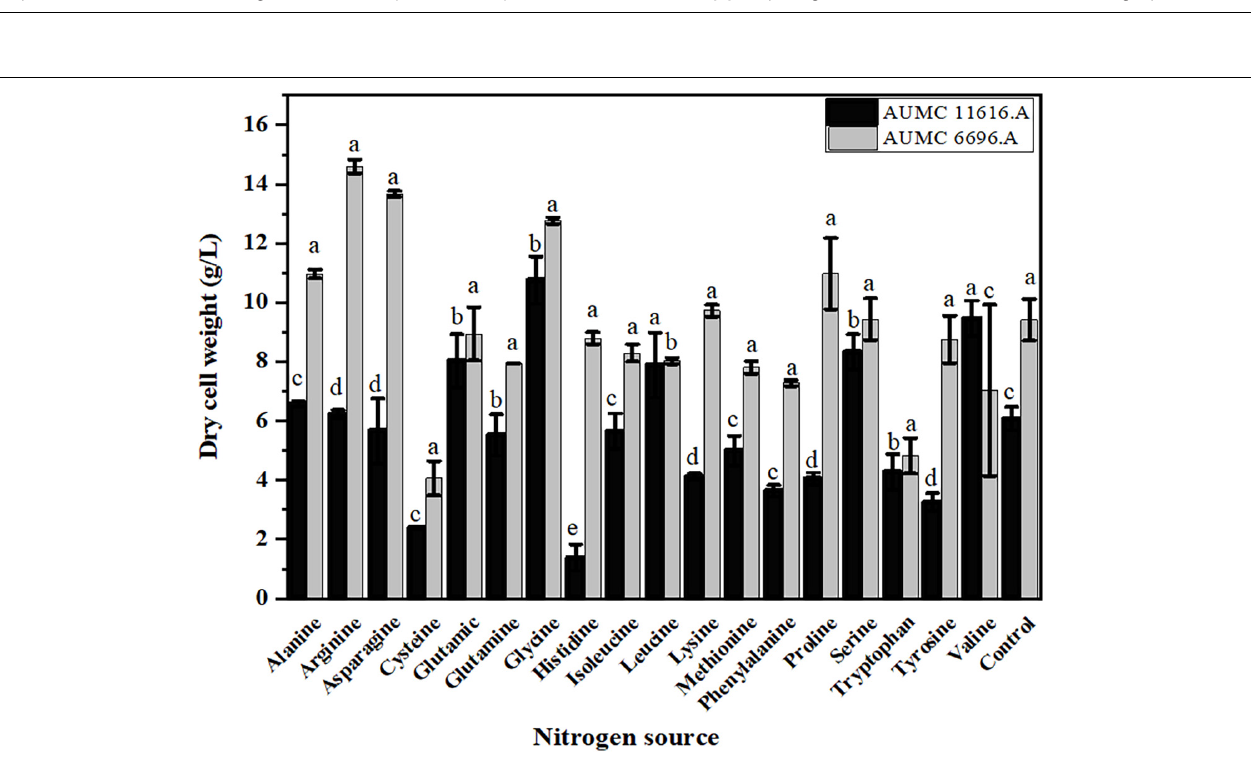
FIGURE 2 | Biomass concentration (g/L) of R. pusillus AUMC 11616.A and M. circinelloides AUMC 6696.A strains grown at 30 ◦ C for 4 days, on different nitrogen sources. Ammonium tartrate was employed as the control. Error bars represent the average standard deviation from three biological replicates. Values that show different superscripts were significantly different from each other using t -test ( p <